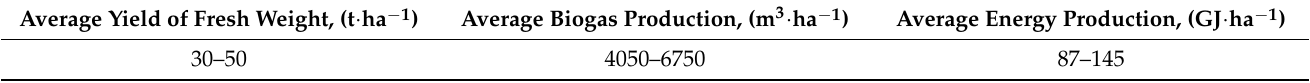
Table 1. Average yields, biogas production, and energy from silage